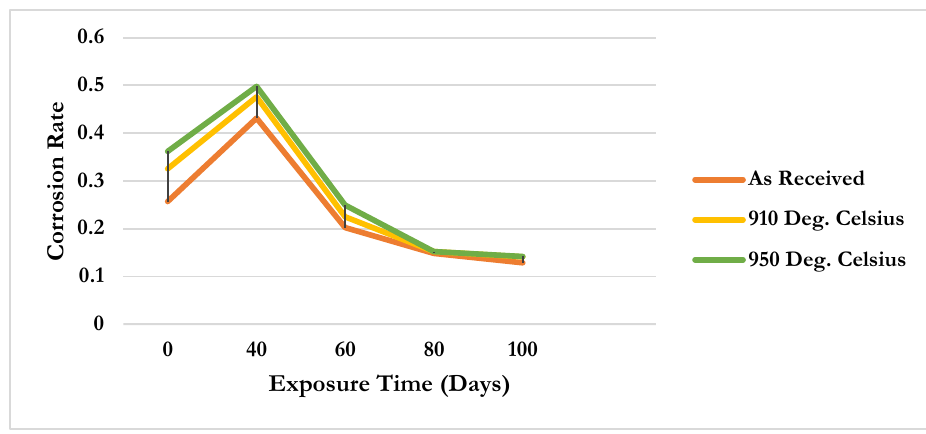
Fig. 2. Corrosion rate against exposure time for post welded annealed medium carbon steel.